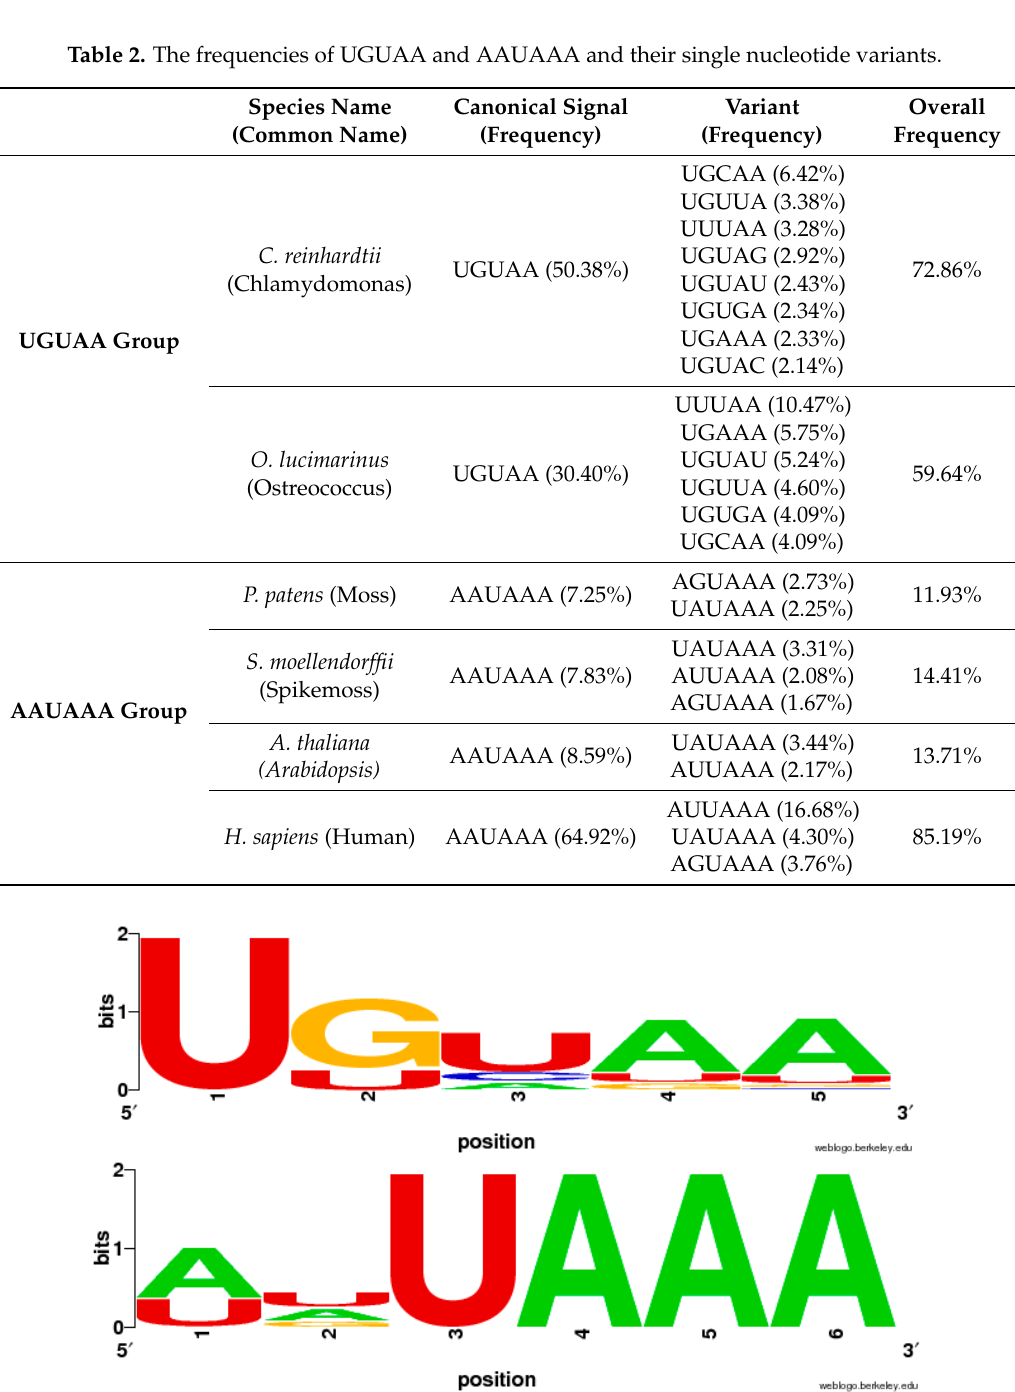
Figure 3. The combined logos of mononucleotide variants from the UGUAA group (top) and two AAUAAA groups (bottom).